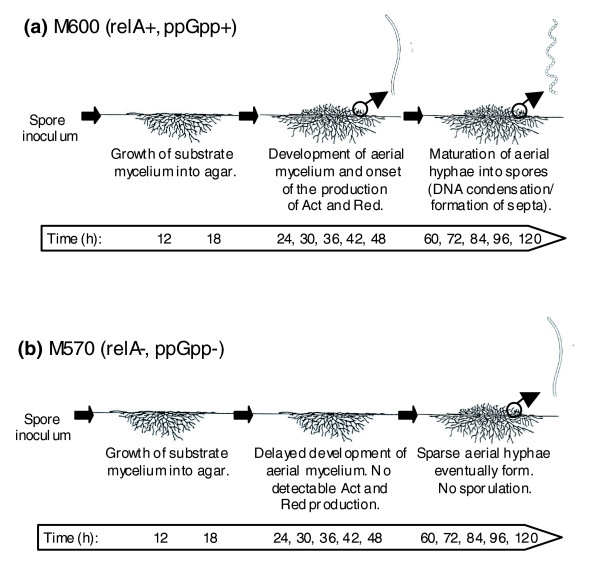
Illustration of the growth and sampling of cultures of (a) M600 (relA+ ppGpp+) and (b) M570 (relA- ppGpp-) on MYM TE agar. M600 progressed normally through its developmental cycle, beginning to erect aerial hyphae after 24 h and to produce the antibiotics Red after 36 h and Act after 48 h. Grey spores were also detectable from 60 h onwards. M570 failed to produce detectable amounts of pigment, and formed only a very sparse covering of aerial mycelium, first observable at 24 h. Samples 1-8 correspond to 12, 24, 36, 48, 60, 84, 96, and 120 h, respectively.